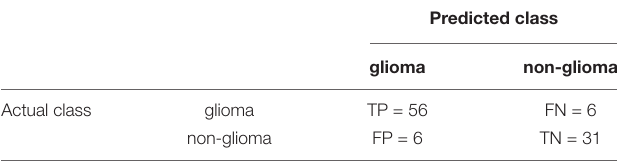
TABLE 3 | Confusion matrix for glioma detection task.